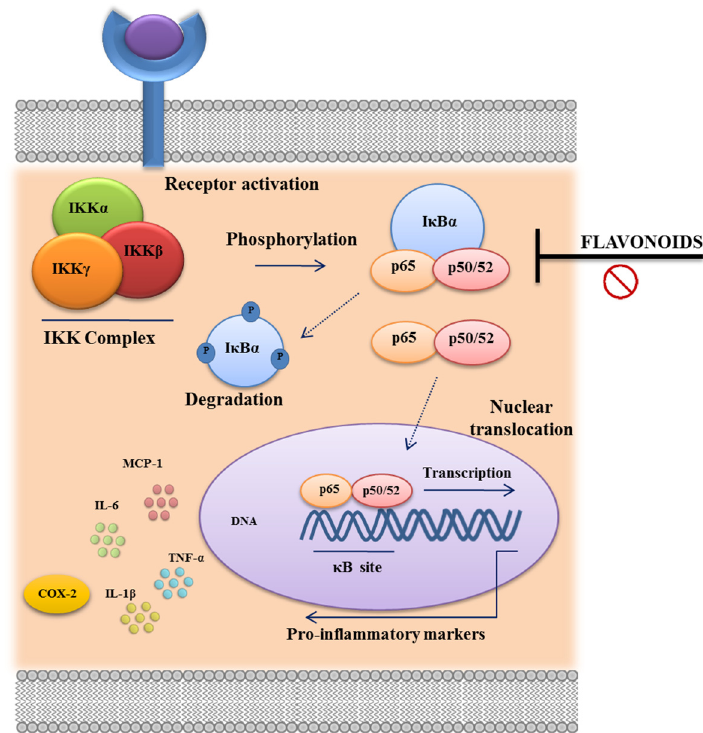
Figure 5. NF ‐ kB signal transduction pathway. NF ‐κ B protein complex (p65–p50) is bound and Figure 5. NF-kB signal transduction pathway. NF- κ B protein complex (p65–p50) is bound and inhibited inhibited by I κ B proteins. Pro ‐ inflammatory cytokines, LPS, growth factors, and antigen receptors by I κ B proteins. Pro-inflammatory cytokines, LPS, growth factors, and antigen receptors activate an activate an IKK complex (IKK β , IKK α , and IKK γ ), which phosphorylates I κ B proteins. IKK complex (IKK β , IKK α , and IKK γ ), which phosphorylates I κ B proteins. Phosphorylation of I κ B Phosphorylation of I κ B leads to its ubiquitination and proteasomal degradation, releasing NF ‐κ B. leads to its ubiquitination and proteasomal degradation, releasing NF- κ B. Active NF- κ B proteins are Active NF ‐κ B proteins are further activated by post ‐ translational modifications (phosphorylation, further activated by post-translational modifications (phosphorylation, acetylation, glycosylation) and acetylation, glycosylation) and translocate to the nucleus where they induce target gene expression, translocate to the nucleus where they induce target gene expression, influencing a broad range of influencing a broad range of biological processes including innate and adaptive immunity, biological processes including innate and adaptive immunity, inflammation, stress responses, B cell development, and lymphoid organogenesis. Anti-inflammatory effects of several flavonoids have been related to the suppression of the NF- κ B signal transduction